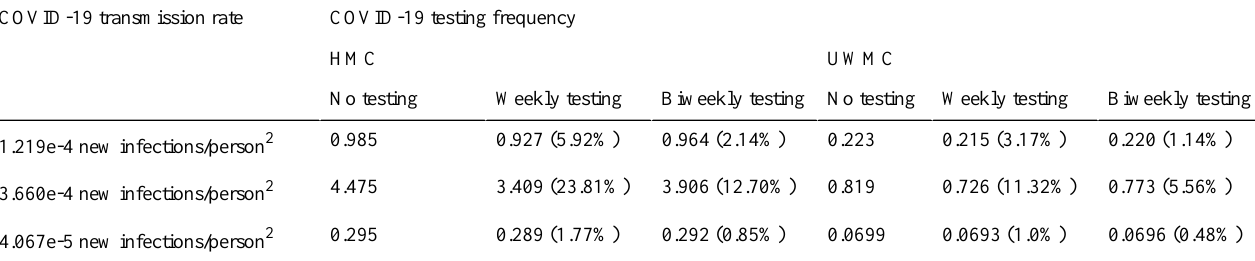
Table 1. New patient infections with and without periodic COVID-19 testing for HCW at HMC and UWMC. Predicted numbers of new patient infections with various transmission rates and COVID-19 testing frequencies for HCW after 180 days within the emergency departments of HMC and UWMC. Percentages in parentheses represent the reduction in the number of infections at the given transmission rate with weekly (every 7 days) or biweekly (every 14 days) testing compared to the number of infections with no routine COVID-19 testing for HCW. HCW: health care workers; HMC: Harborview Medical Center; UWMC: University of Washington Medical Center.